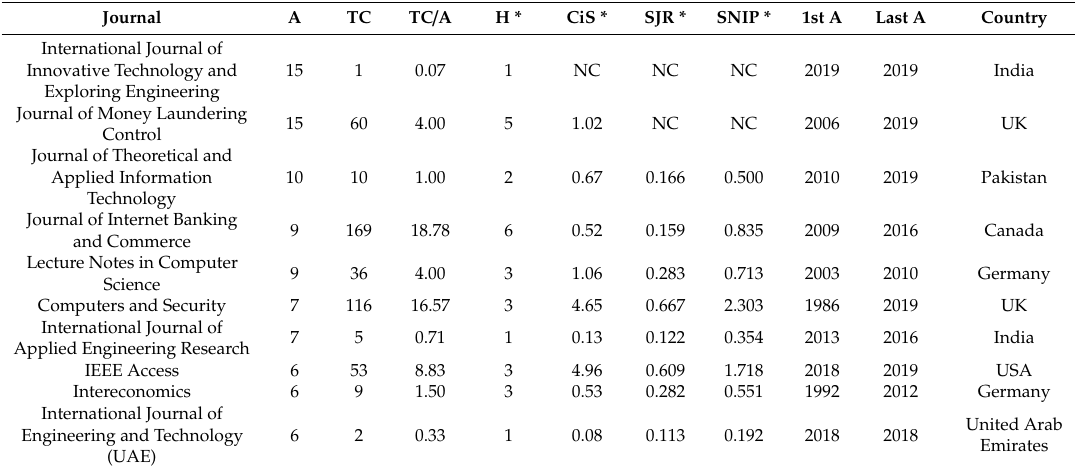
Table 3. Main Journals on financial transactions